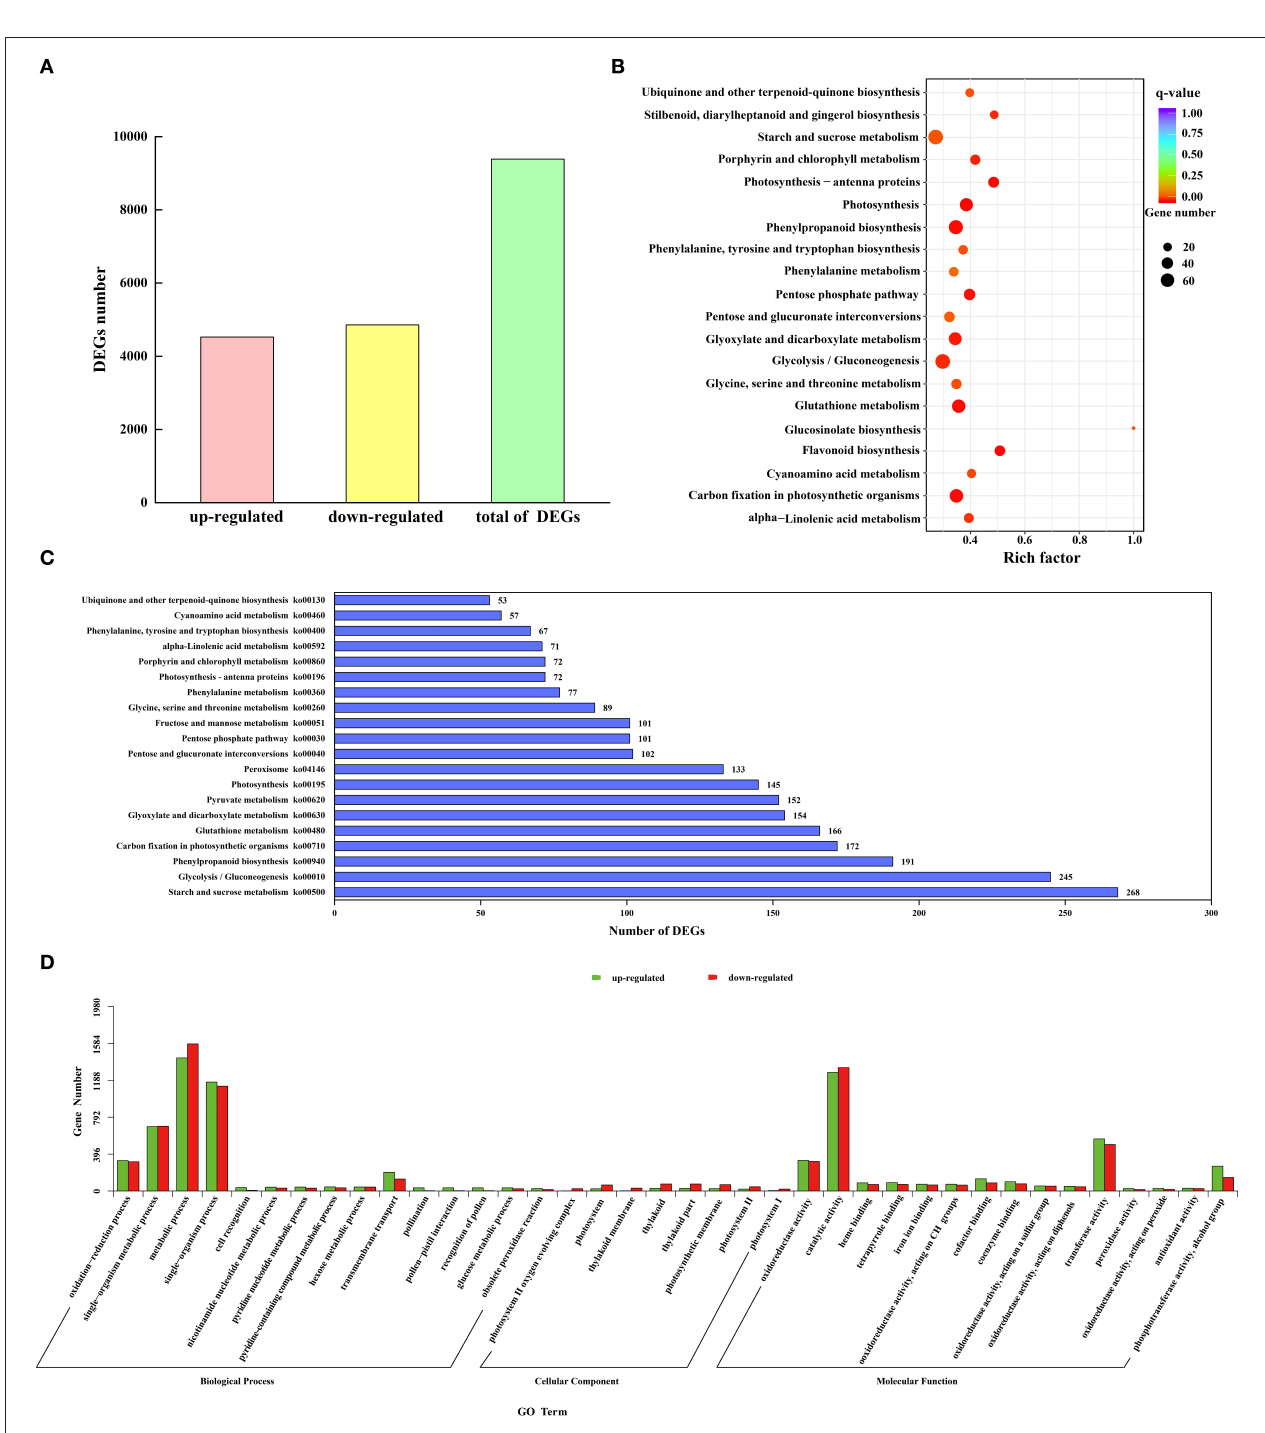
FIGURE 5 | Identification and functional annotation of DEGs. (A) The number of upregulated and downregulated DEGs. (B) Q-value distribution of the top 20 enrichment pathways. (C) Enrichment of the top 20 KEGG pathways of all DEGs. (D) GO enrichment results of upregulated and downregulated DEGs.